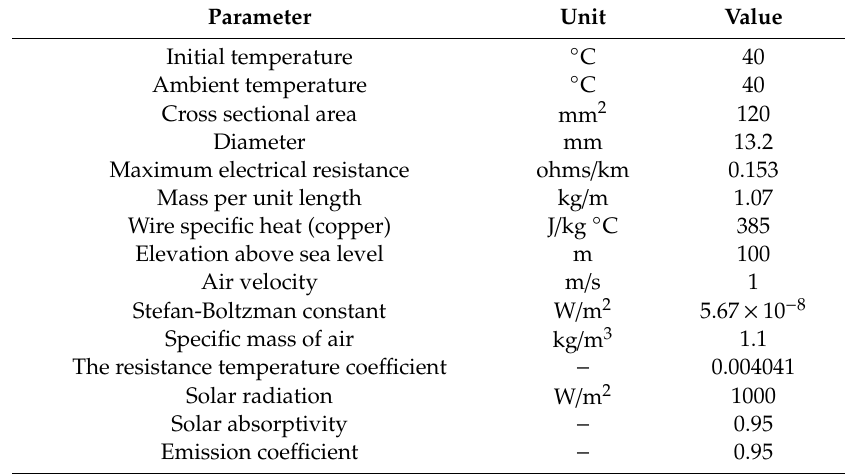
Table A7 presents assumed input parameters for temperature calculations (OCS 120 mm 2 copper contact wire). The temperature input parameters were considered for Warsaw (Poland). Table A7. Input parameters for a 120 mm 2 copper contact wire temperature calculations